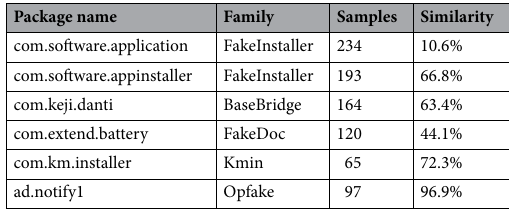
Table 2. Fuzzy Hash-based similarity results.